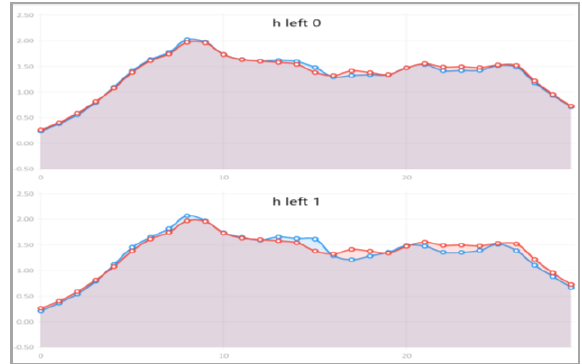
Figure 13. Diagrams of odontometric parameters at the initial sectioning direction (red line) and two deviations: adjacent to it (upper blue line) and next one (lower blue